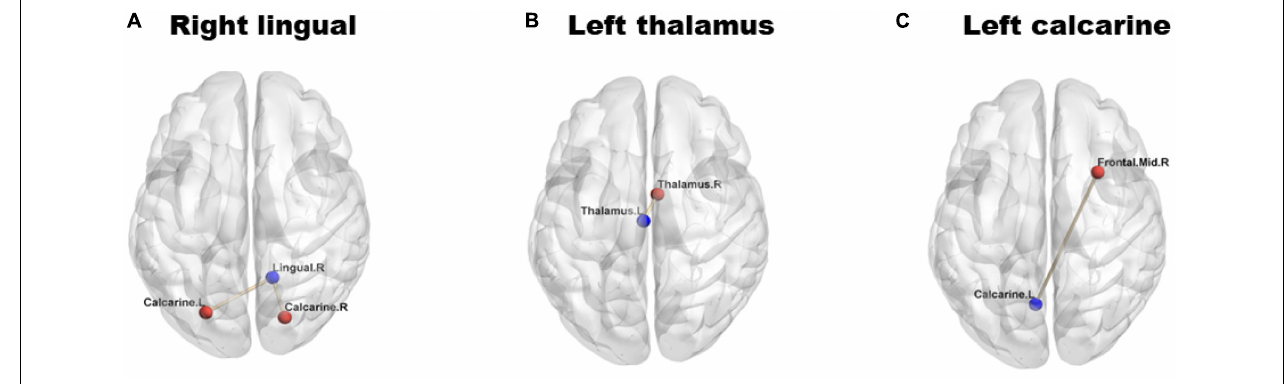
FIGURE 2 | Group differences in functional connectivity (FC) between individuals with neuromyelitis optica spectrum disorder (NMOSD) and controls. The blue dots represent the seed points, and the red dots represent the remaining brain regions displaying differences in FC. The lines represent the functional connections between the seed points and the different brain regions. (A) shows the right lingual gyrus; (B) shows the left thalamus; (C) shows the left calcarine gyrus. The FC values in right lingual gyrus (A) , left thalamus (B) and left calcarine gyrus (C) were significantly reduced ( P < 0.05) in NMOSD patients when compared to HC.